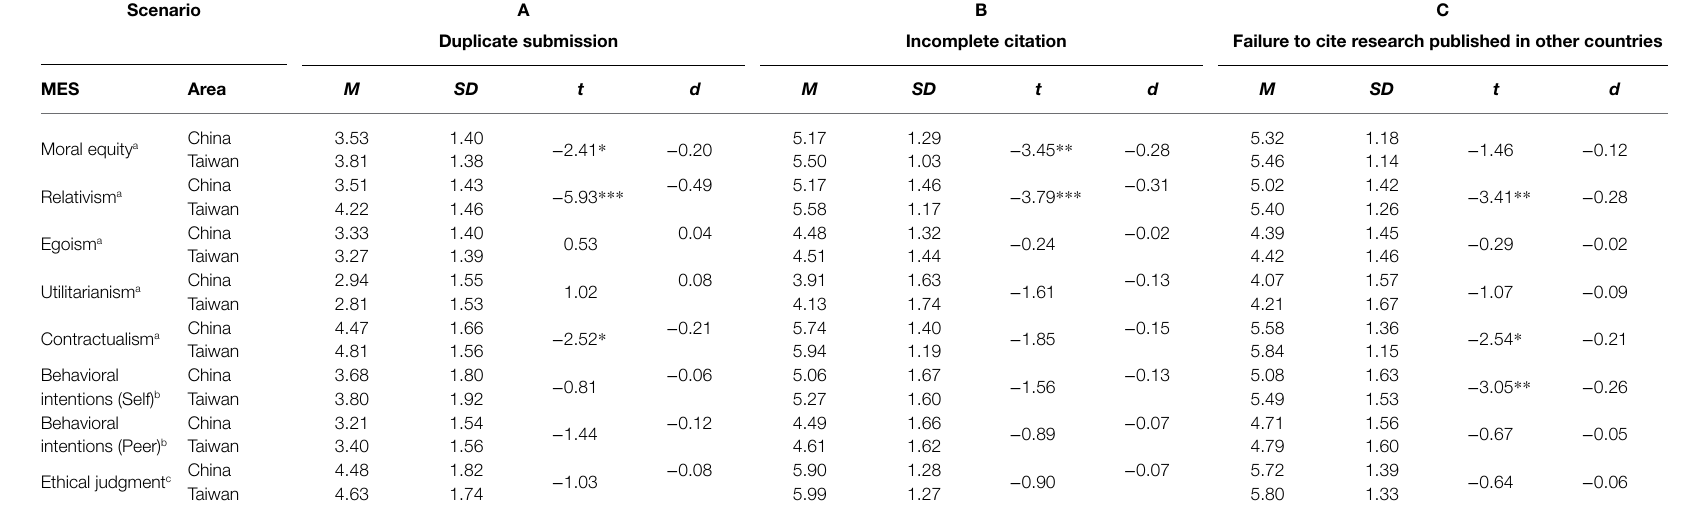
TABLE 2 | Geographical area differences in responses across AD